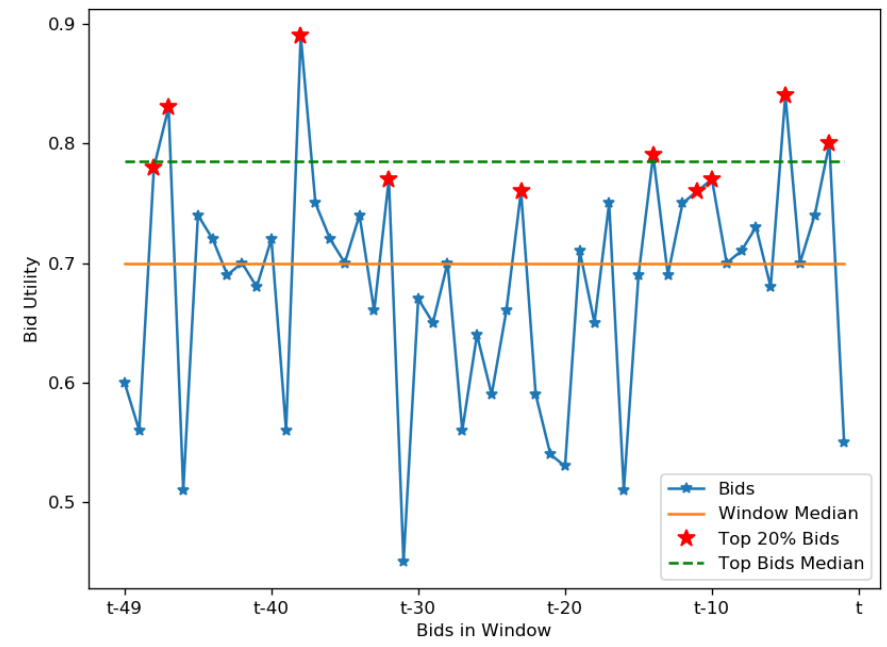
Figure 4. An example of the top median mechanism for z =